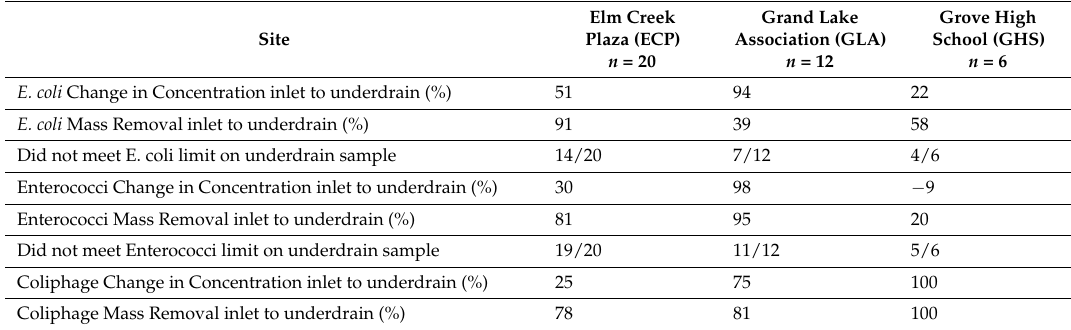
Table 6. Microbial analysis from paired storm events from the inlet and underdrain of three bioretention cells in Grove, Oklahoma from May 2014 to October 2015.